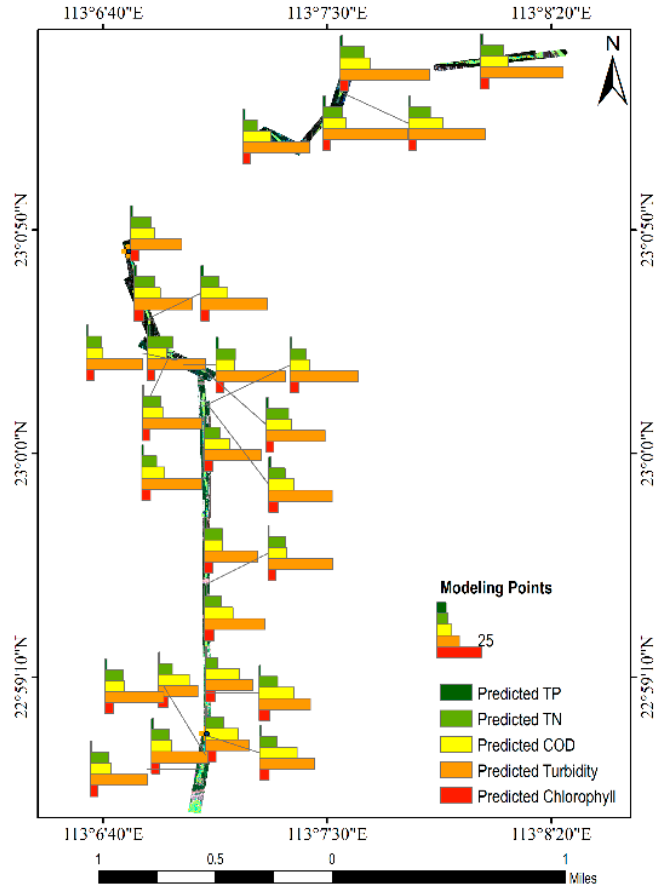
Figure 15. The prediction results of five water quality parameters at modeling